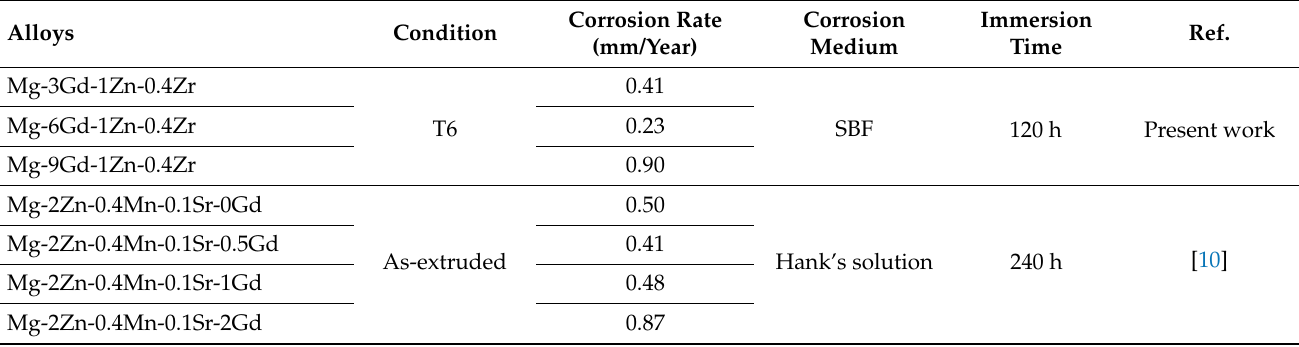
Table 6. The corrosion rates of biomedical Mg